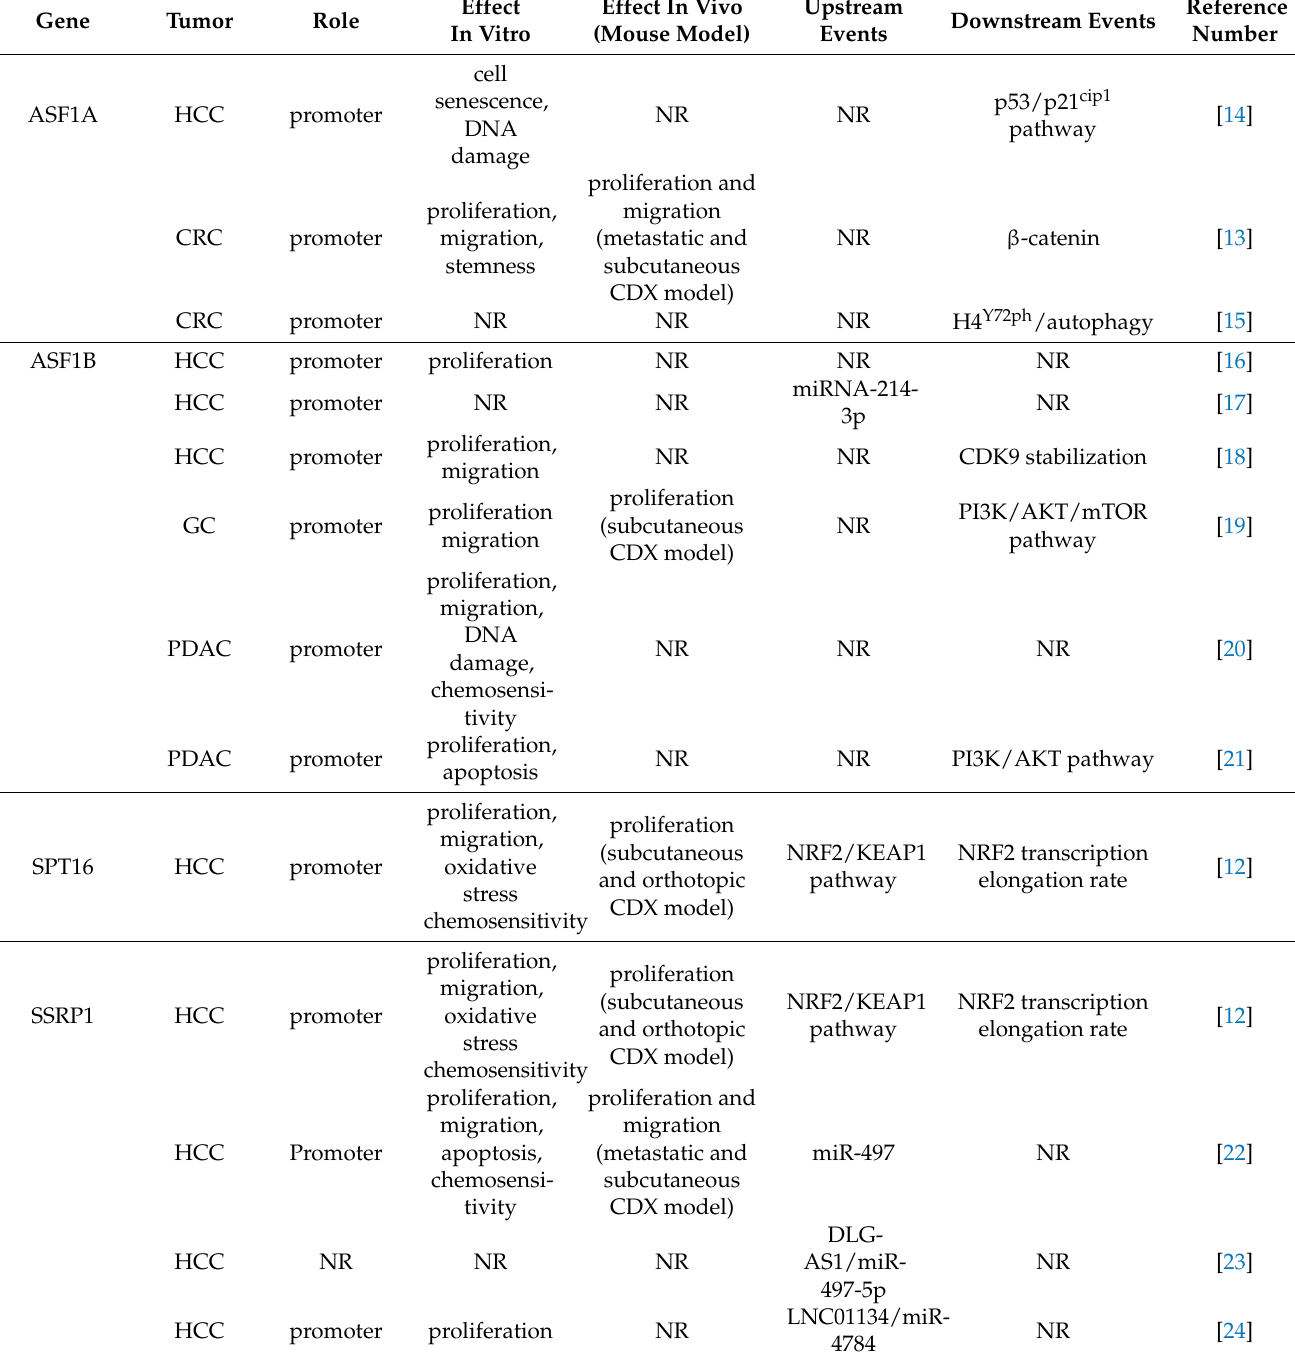
Table 1. Phenotype and mechanism of selected histone chaperones in digestive